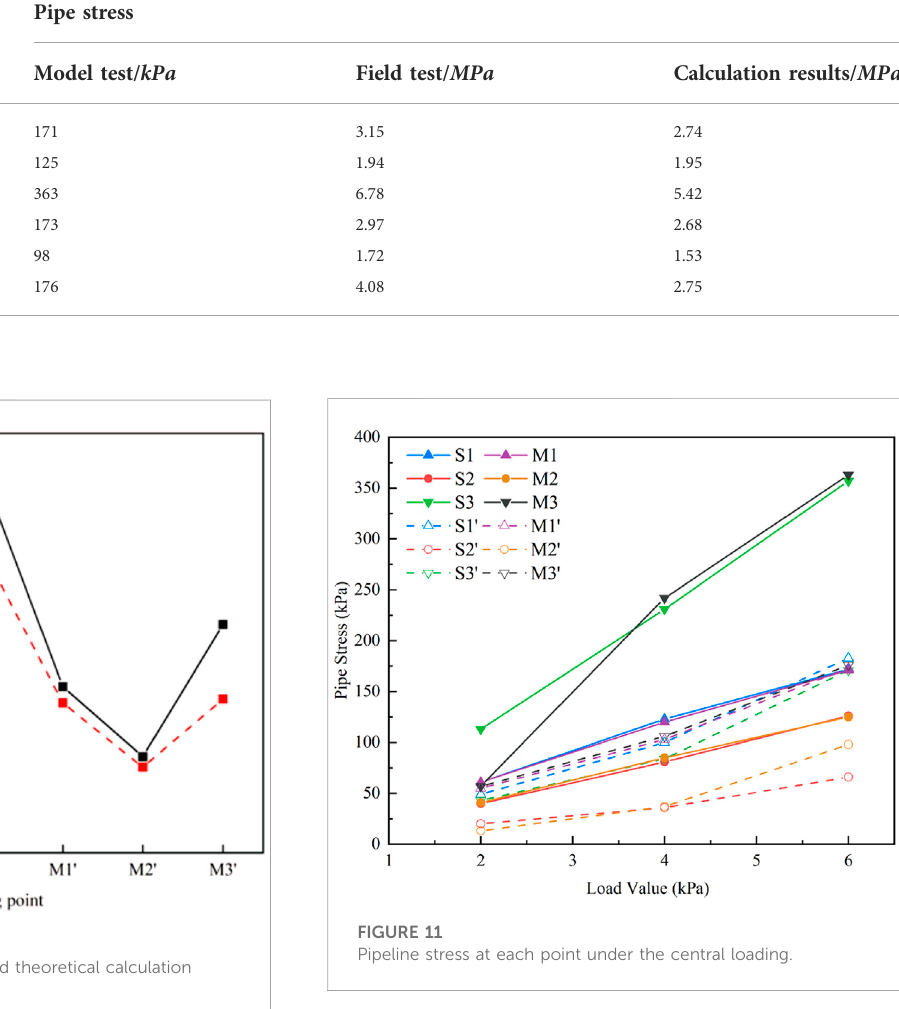
TABLE 4 Comparison between fi eld test stress and theoretical calculation.